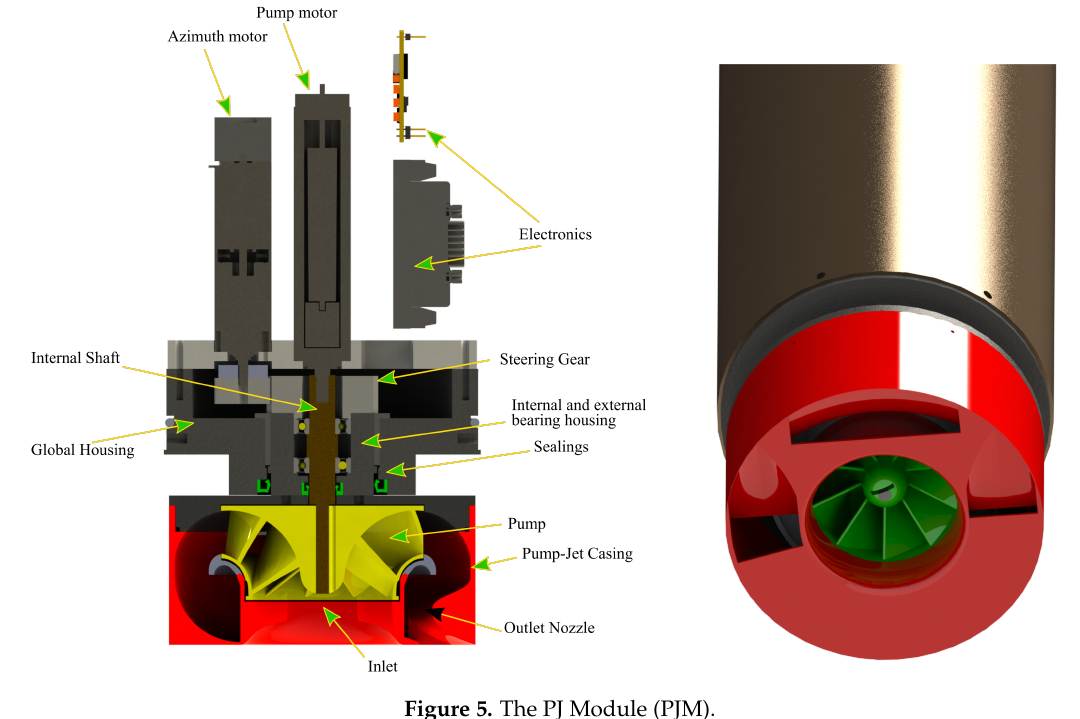
Figure 5. The PJ Module